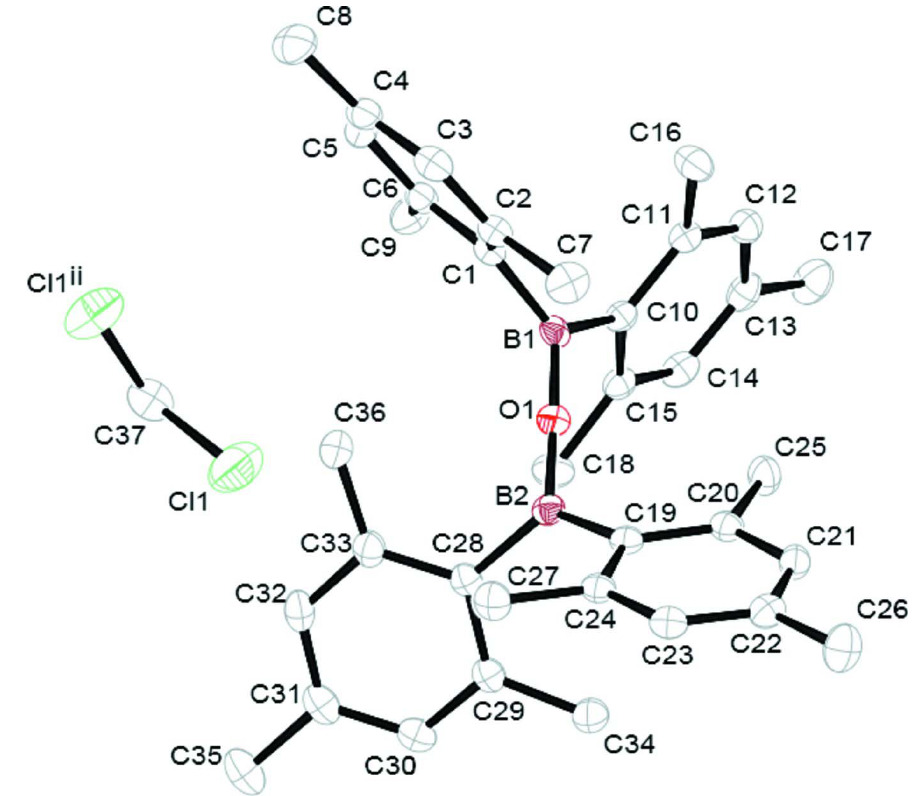
Figure 1 The molecular structure of the title compound with displacement ellipsoids drawn with 50% probability. H atoms are omitted. Symmetry code (ii): - x , y , - z +